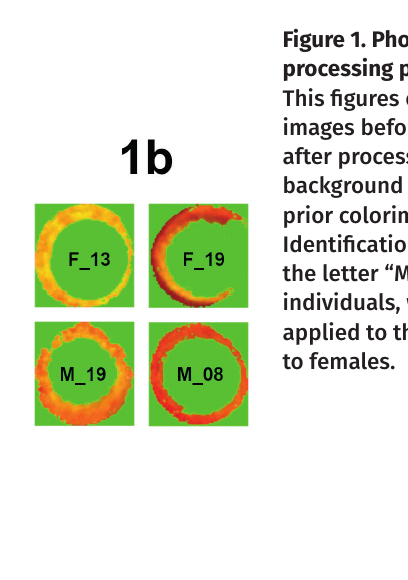
color composition of each image, emphasizing predominance of similar pixels color values.